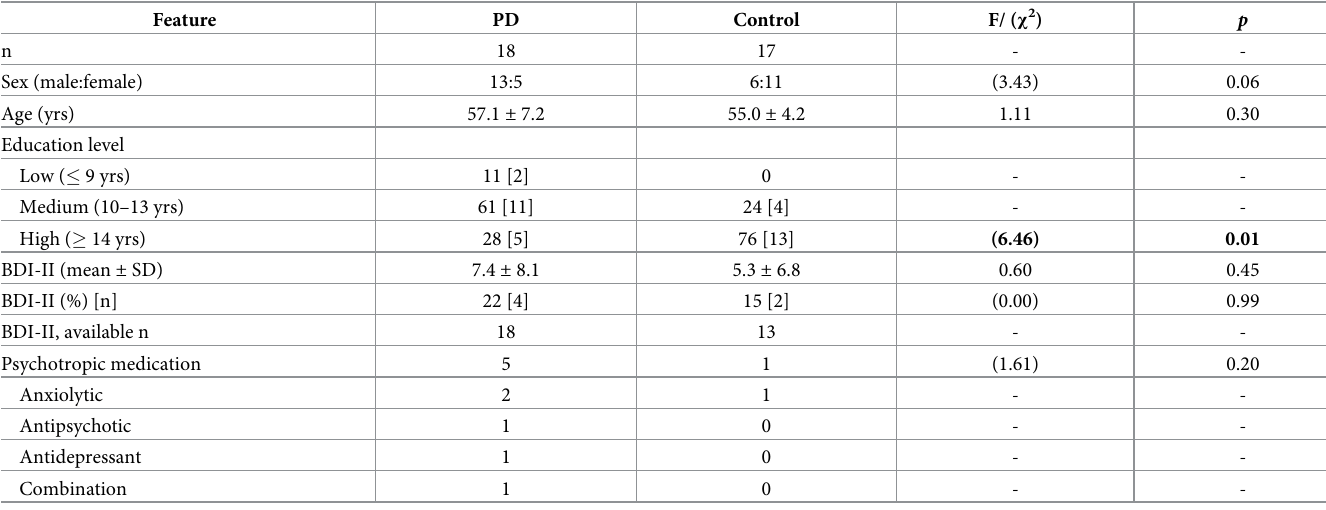
Table 2. Demographic and clinical characteristics of